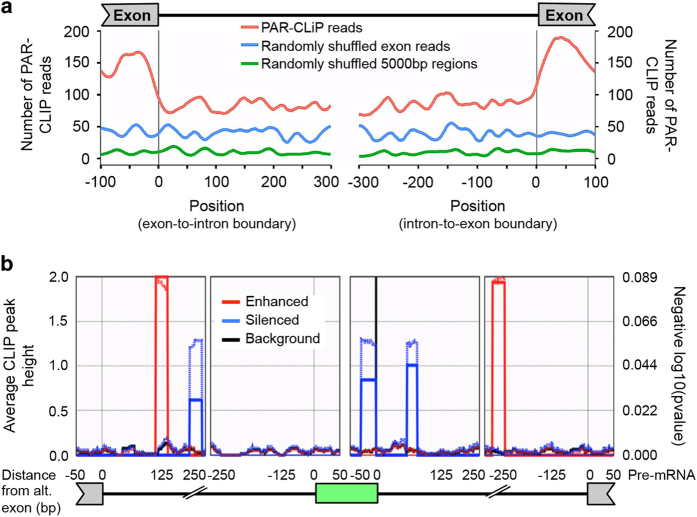
Positional analysis of PARP1-PAR-CLIP tags, with respect to splicing functions. (a) The number of PAR-CLIP sequences covering exon boundaries (red) compared to the number of sequences covering randomly shuffled exons (blue) and randomly selected 5 000-bp regions (green). (b) Maps for PARP1-PAR-CLIP read enrichment for the skipped exon events from RNA-seq of PARP1 knockdown and control (non-targeting siRNA) experiments are shown for enhanced (red) and silenced (blue) splicing events. Solid lines represent the peak quality score (peak height) as scaled on the left. Dotted lines represent the significance score (P-value) as scaled on the right. The level of significance was determined by comparison to a ‘Background set’ of 32 114 of non-impacted alternative exons (rMATs FDR >50%) in expressed genes (FPKM>5.0). Only events showing P≤0.05, FDR≤0.05, and a minimum inclusion level difference ≥0.1 were considered. The green box indicates the PARP1-regulated exon.